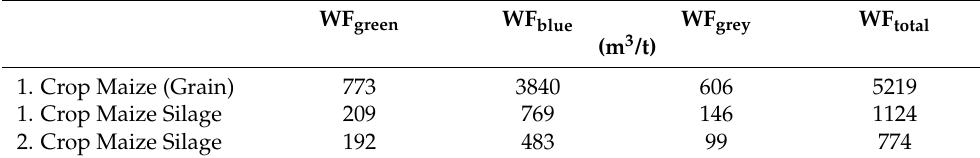
Table 4. The water footprint (WF) of maize